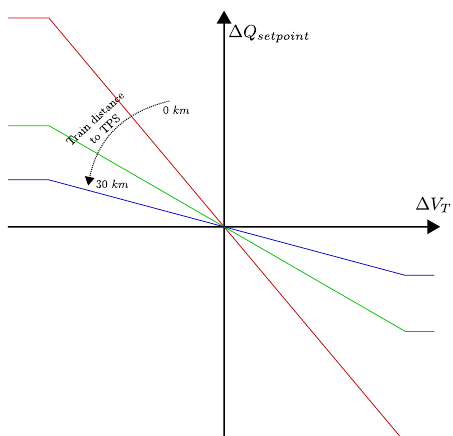
Figure 20. Droop strategy for on-board adjustment. The ∆ V T is the difference between the real train voltage and the expected train voltage. The ∆ Q setpoint is the output of the droop curve, where this value is added to the predicted Q comp .